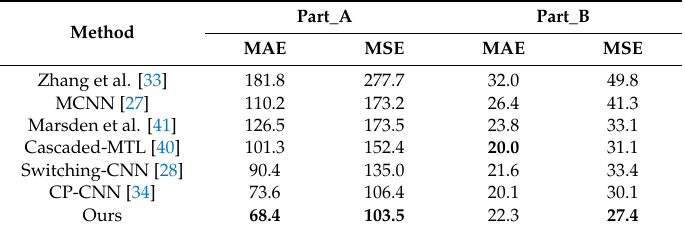
Table 2. The comparison on ShanghaiTech